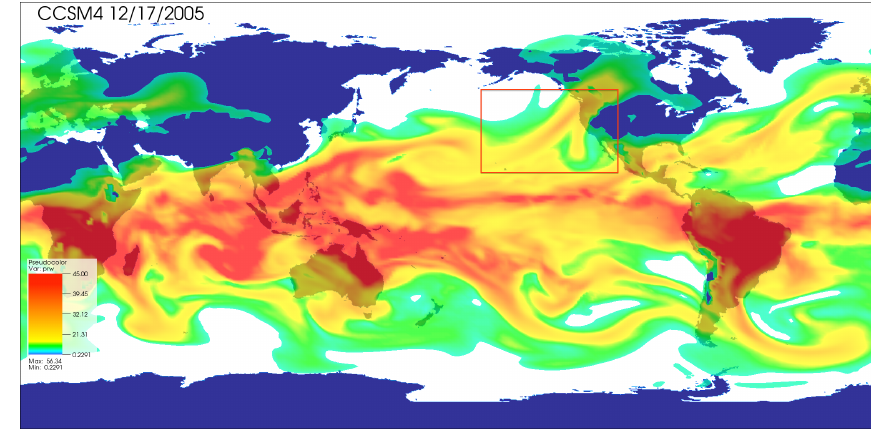
Figure 1. Total daily precipitable water (prw) field (in kgm − 2 ) from a sample of the CCSM4 model output. It shows a typical AR that originated at the tropical region near Hawaii as it reaches the western coast of the US and is identified by the TECA detection